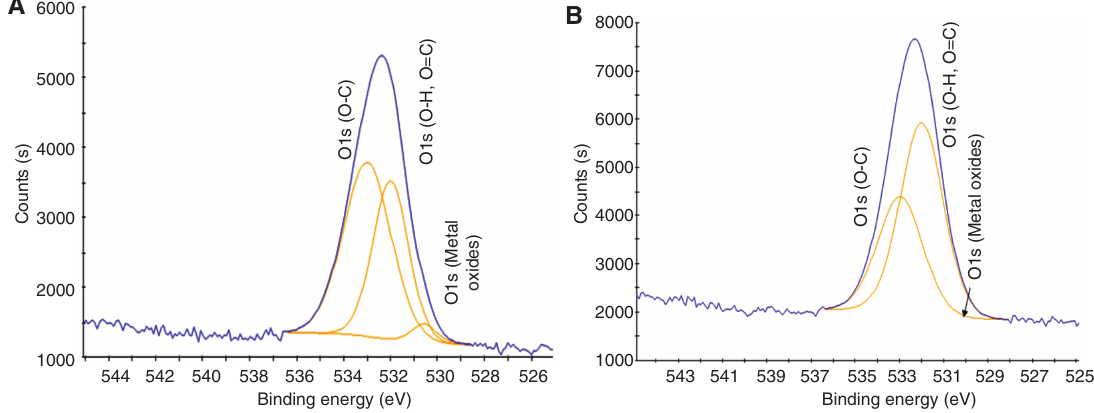
Figure 4 X-ray photoelectron spectroscopy (XPS) survey on O1s regions of ‘green’ (A) TEA-Fe and (B) CAF-Fe catalysts.